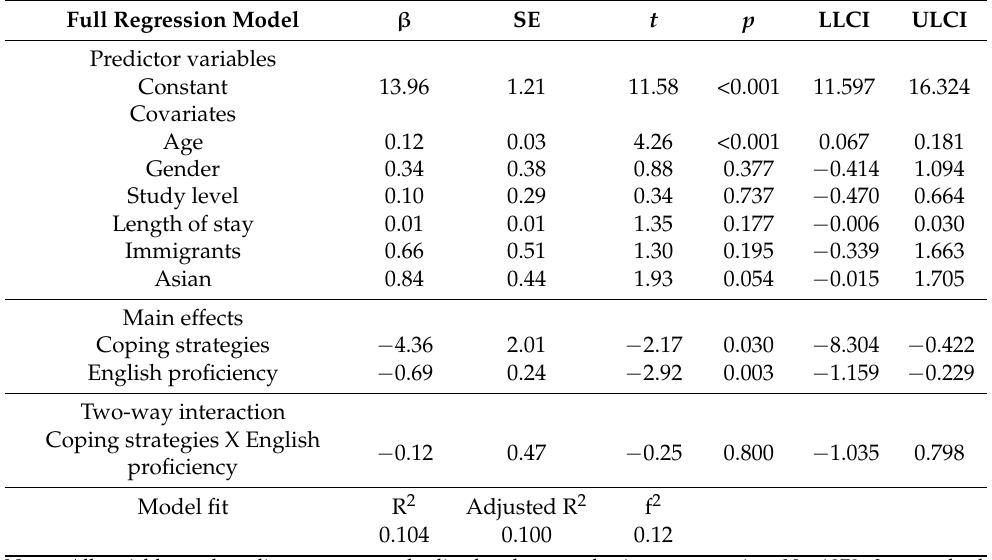
Table 6. Moderation analysis for coping strategies, English proficiency, and depression. Full Regression Model